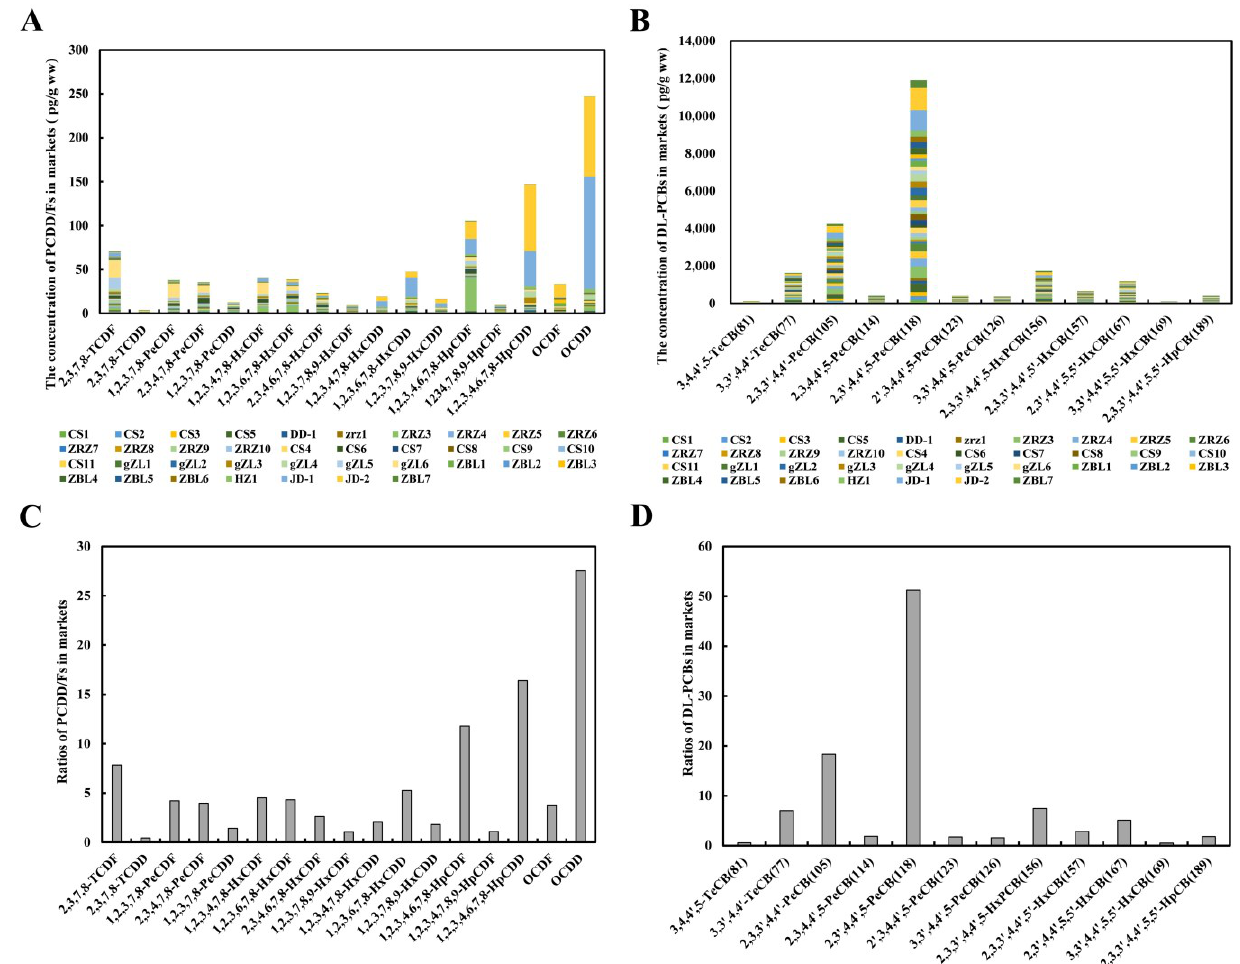
Figure 4. Concentrations of PCDD/F ( A ) and DL-PCB ( B ) in Chinese mitten crabs from markets ( n = 555). PCDD/F ( C ) and DL-PCB ( D ) ratios in Chinese mitten crabs from markets. The PCDD/F and DL-PCB detection rates in the market crab samples were 100%, and in some samples, the TEQ ranges of the PCDD/Fs and DL-PCBs exceeded the relevant limits [27]. The total PCDD/F and DL-PCB TEQ levels in the market crab samples ranged from 0.33 to 10.80 pg TEQ/g, and the mean was 2.67 pg TEQ/g. The total PCDD/F TEQs ranged from 0.11 to 8.80 pg TEQ/g, and the mean was 1.56 pg TEQ/g. The total DL-PCB TEQs ranged from 0.23 to 2.35 pg TEQ/g, and the mean was 1.11 pg TEQ/g. TEQs of the total PCDD/F and DL-PCB contents in 8% of the samples were higher than the relevant limit (6.5 pg TEQ/g for the total PCDD/Fs and DL-PCBs) [27]. The TEQ of the PCDD/Fs in 14% of the samples was higher than the relevant limit (3.5 pg TEQ/g for PCDD/Fs) [27]. The TEQs of the total PCDD/Fs and DL-PCBs found in market crabs are shown in Table S6. TEFs were used to determine the TEQ distribution of individual congeners. 1,2,3,7,8-PeCDD; 2,3,4,7,8-PeCDF; and 2,3,7,8-TCDF contributed 22%, 19%, and 12%, respectively, and the TEQs of the remaining congeners accounted for less than 10%. Among the DL-PCBs, 3,3 (cid:48) ,4,4 (cid:48) ,5-PeCB (89%) are the main contributors to the TEQs of the DL-PCBs, followed by 3,3 (cid:48) ,4,4 (cid:48) ,5,5 (cid:48) -HxCB (8%) and 2,3 (cid:48) ,4,4 (cid:48) ,5-PeCB (0.8%). The toxicity equivalent factors of the 17 PCDD/Fs and 12 DL-PCBs were determined according to the WHO-TEF standards (Table S2) that were revised by WHO in